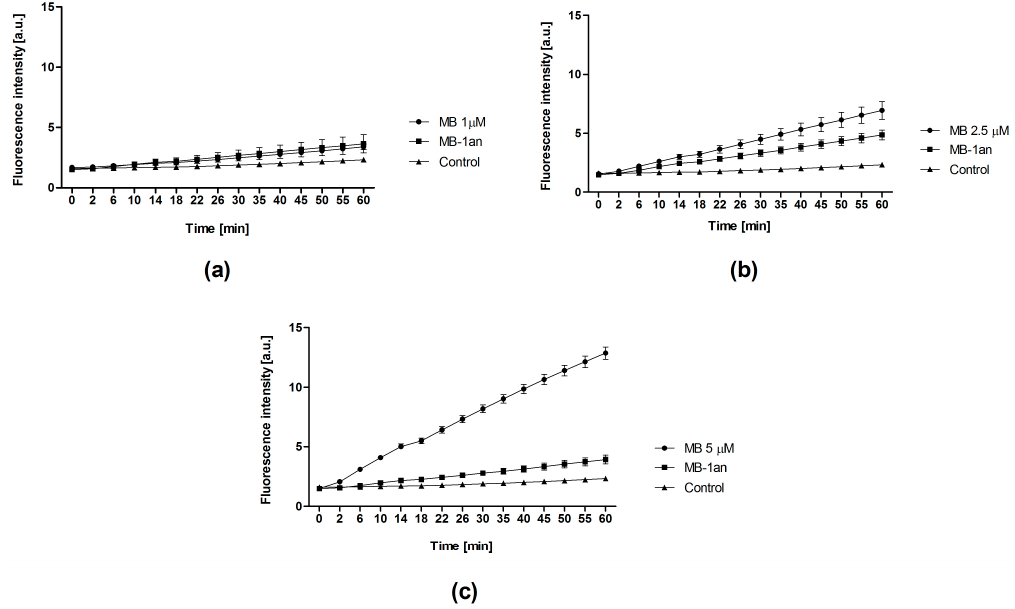
Figure 1. The fluorescence intensity of the singlet oxygen sensor green (SOSG) probe in the presence of different concentrations of methylene blue (MB) and methylene blue-dendrimer complex (MB-1an): 1 µM ( a ); 2.5 µM ( b ); and 5 µM ( c ) versus the time of irradiation.